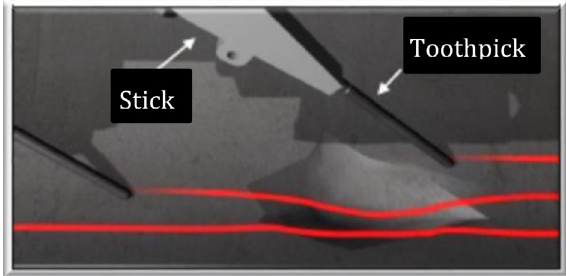
Fig. 2. Toothpick sensors pro fi ling a